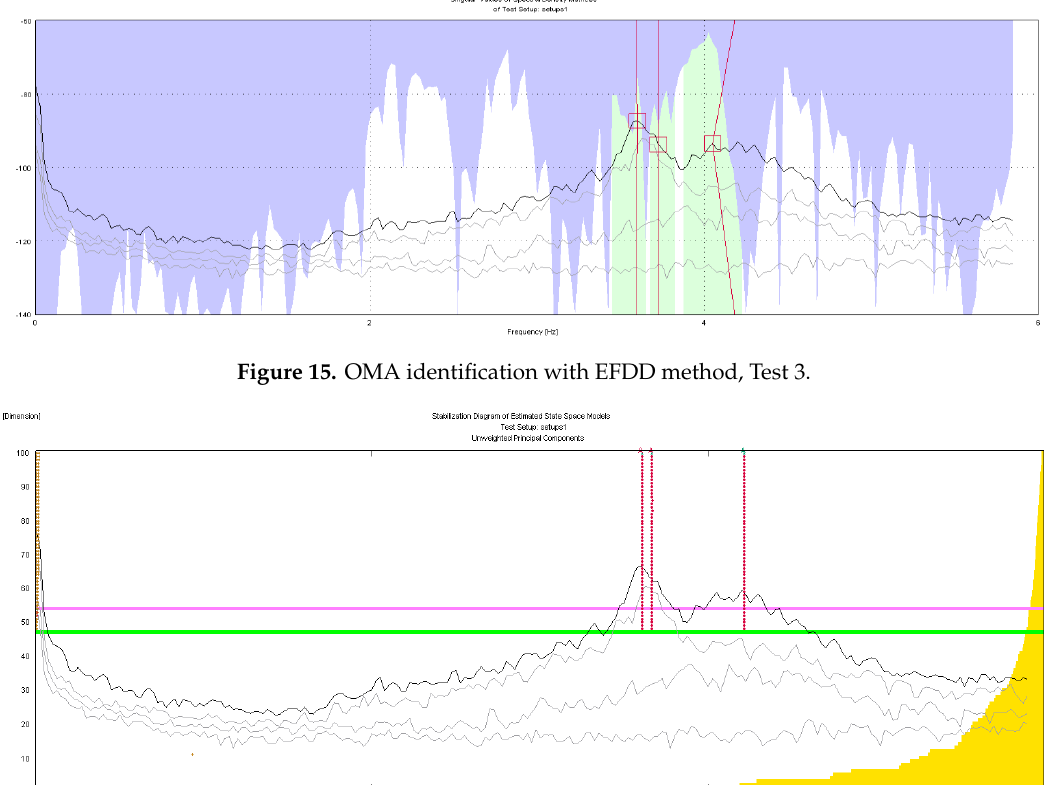
Table 2. Experimental identified frequencies [Hz] with SSI and EFDD techniques and mode shape type.